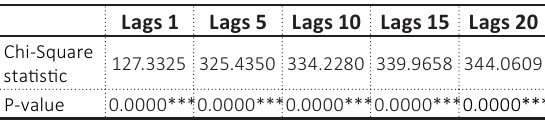
Table 1. Test results for heteroscedasticity in returns